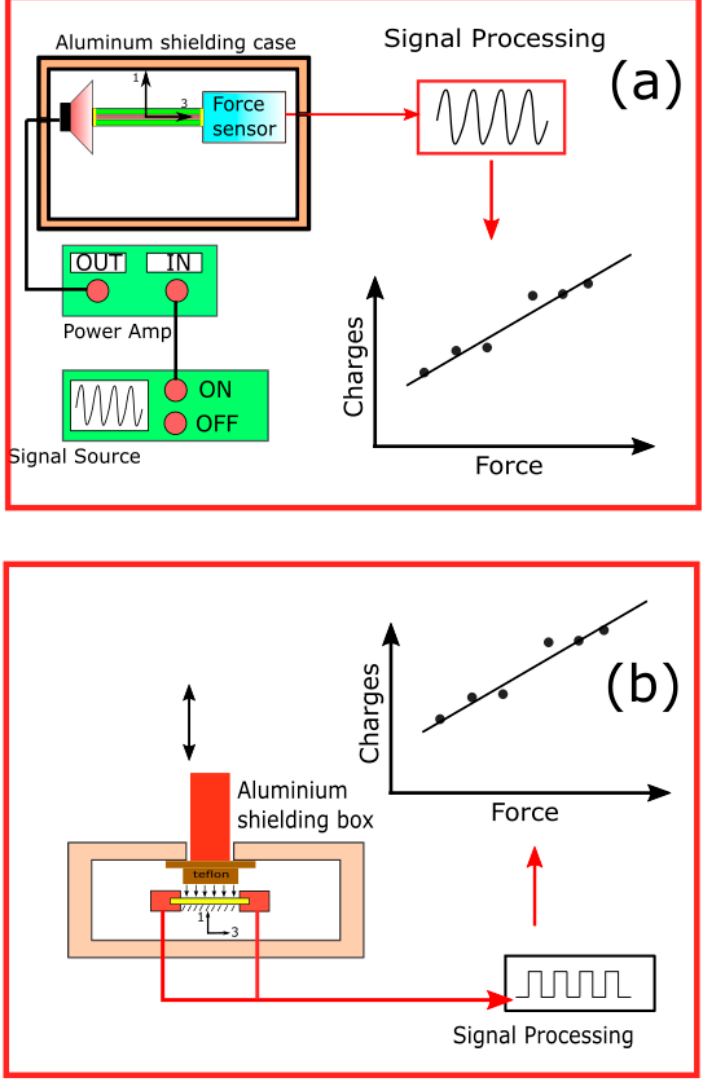
Figure 6. Experimental setup to measure the piezoelectric coefficients ( a ) d 33 and ( b ) d 13 .